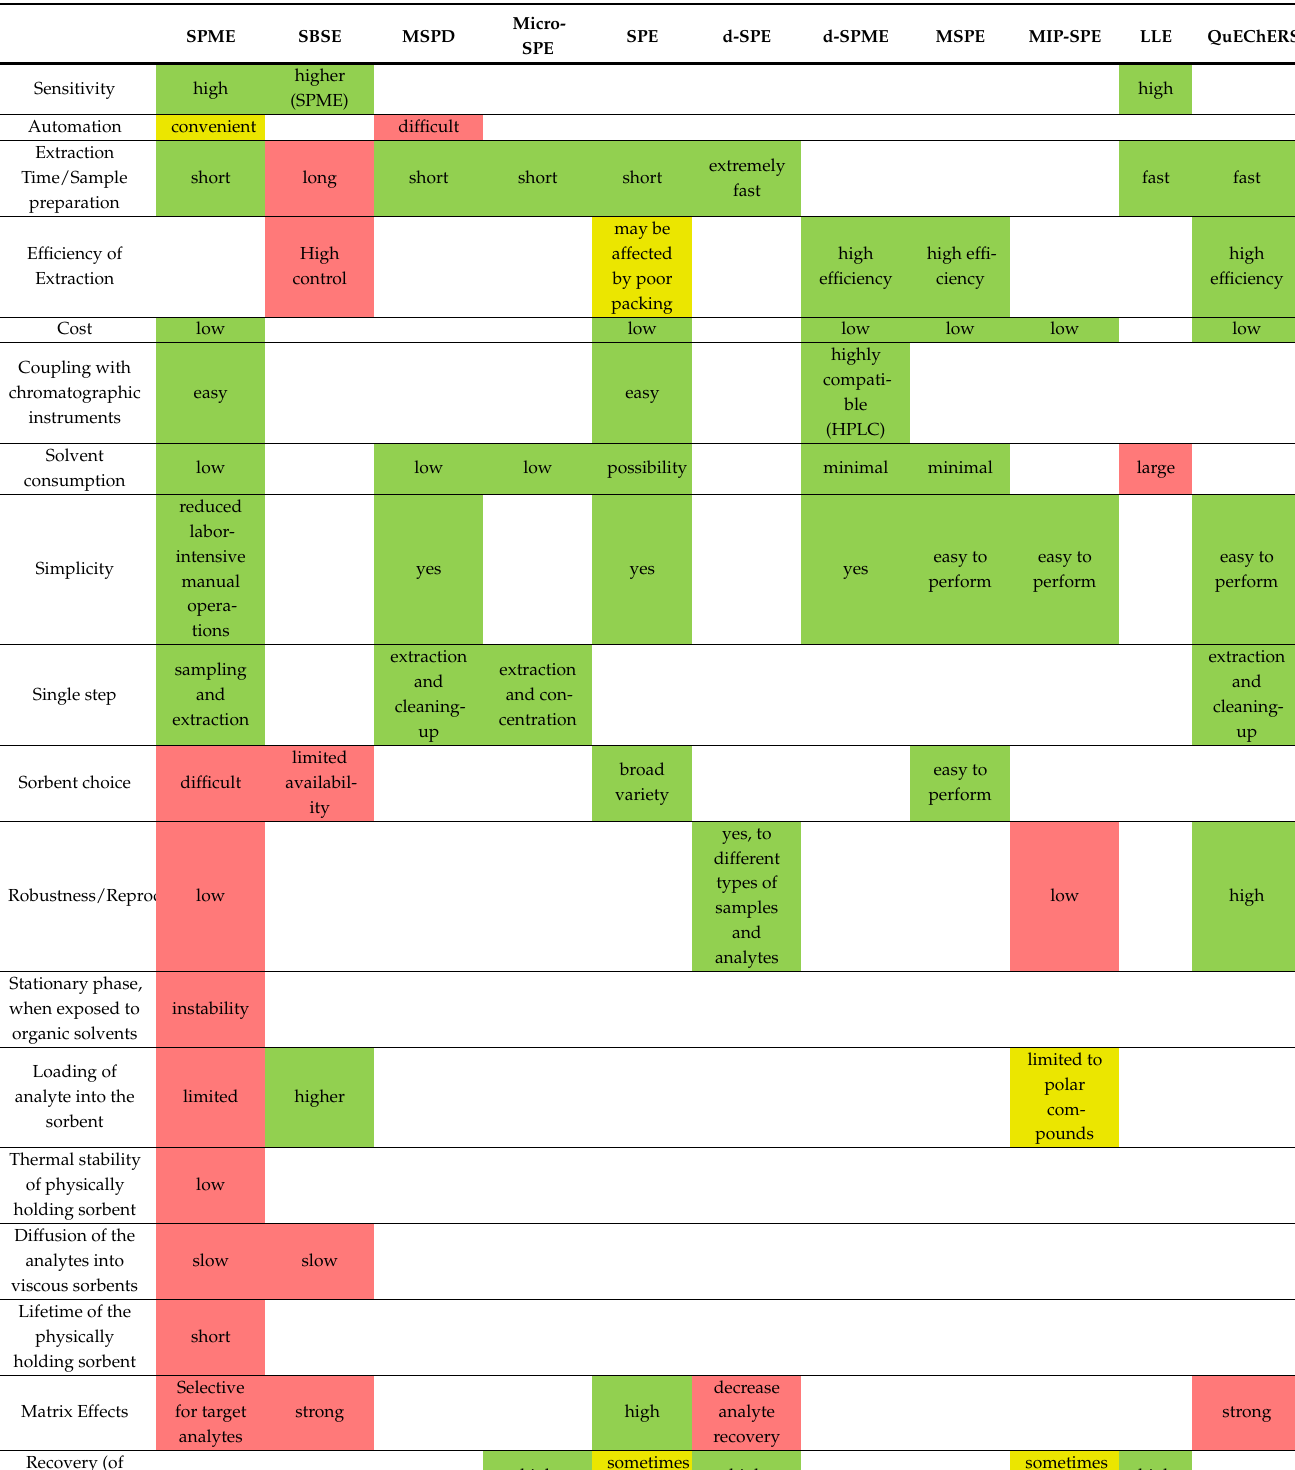
Table 3. The main extraction techniques for determination of antibiotic residues in foodstuffs under the concept of green chemistry methods (greenness factors): advantageous factors are shown in green, factors with limitations in yellow and disadvantageous factors are shown in